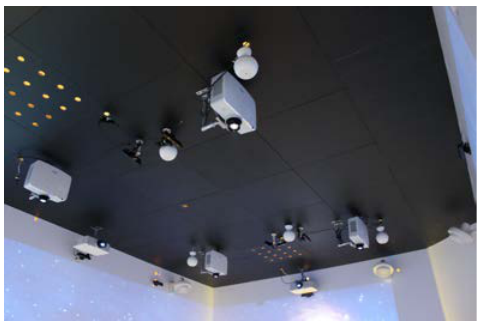
Figure 2. An image of projectors, kinects and fans are installed on the ceiling.